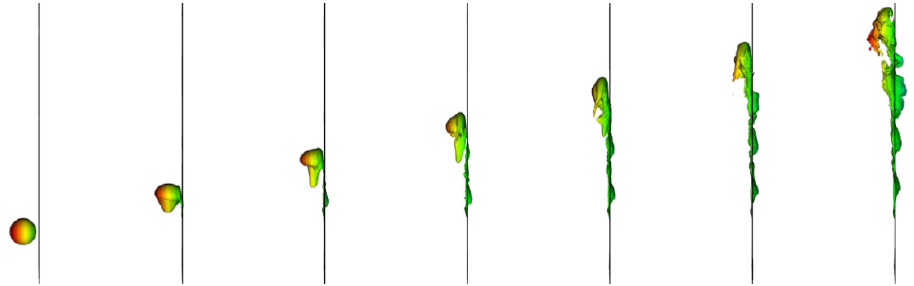
Figure 9 . Simulation of the droplet deposition process in an upwards annular two-phase flow (side view) [200].